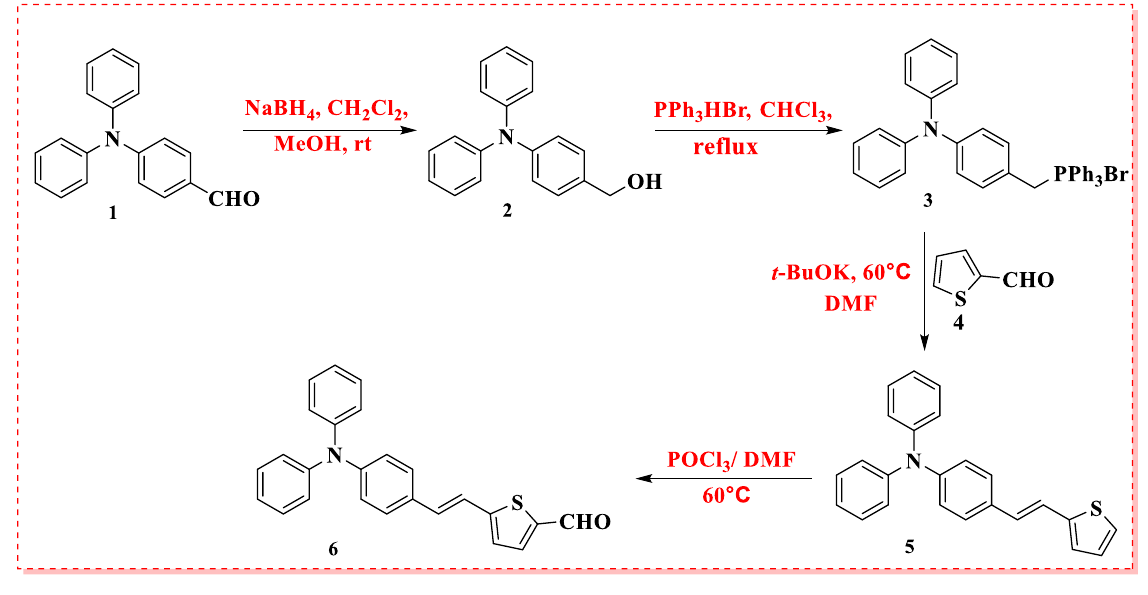
Figure 2. Synthesis of 5-(4-(diphenylamino) styryl)thiophene-2-carbaldehyde ( 6